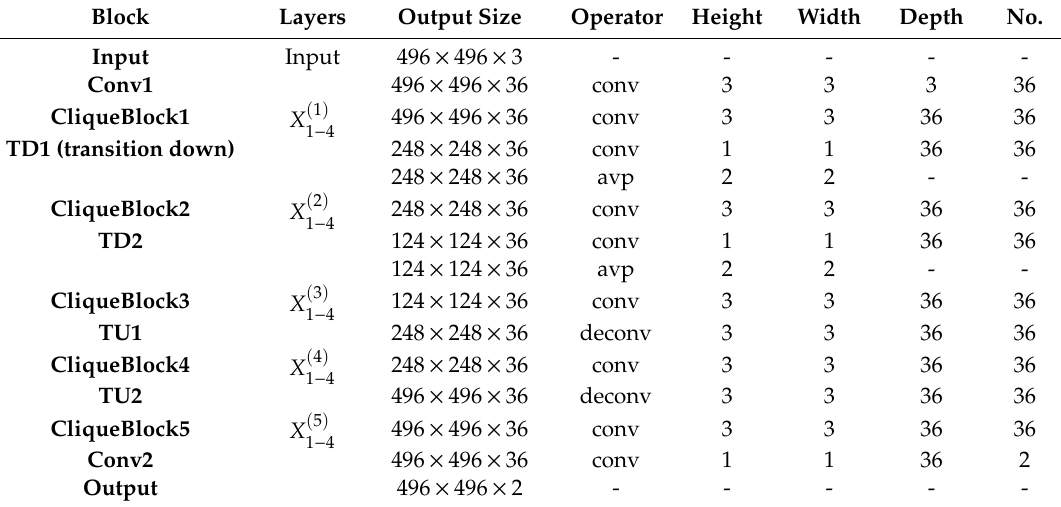
Table 1. Detailed properties of parameters for all layers.